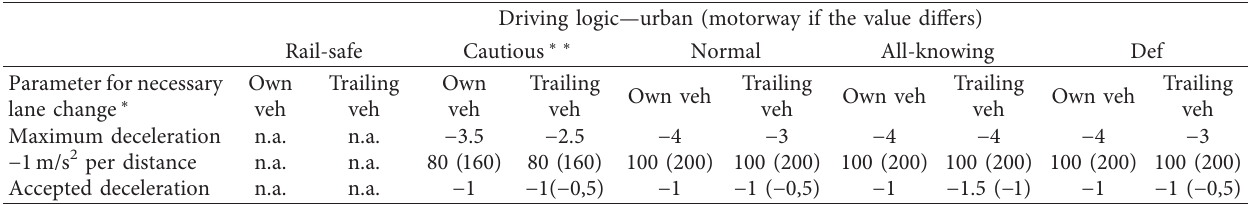
Table 3: Recommended driving behaviour parameters for necessary lane change in Vissim.